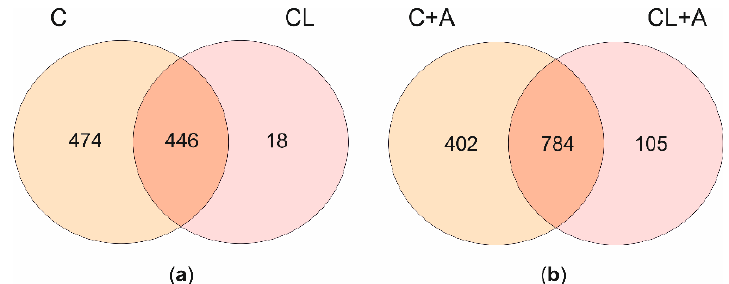
Figure 4. Transcriptional effects of curcuminoids. The Venn diagrams report the number of unique and shared DEGs after C and CL treatments ( a ), and after C + A and CL + A cotreatments ( b ). C = curcumin; CL = Curcuma longa ; A = AFB1.